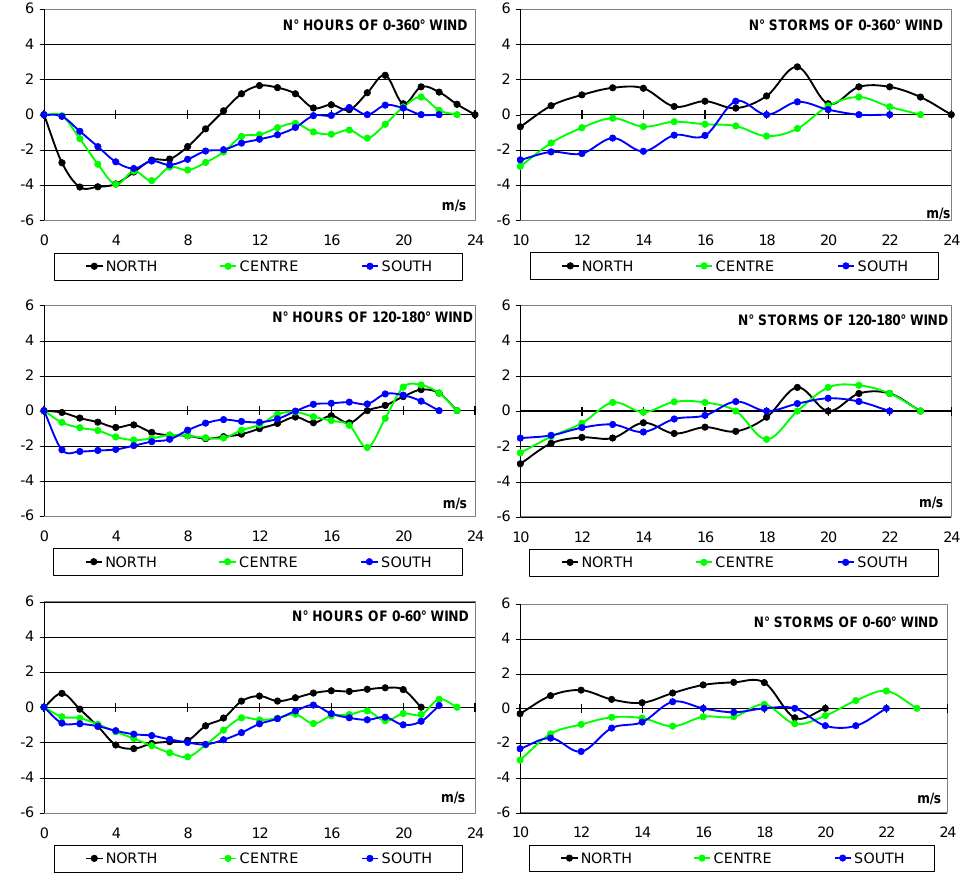
Figure 7. t-test statistics for cumulated number of hours above fixed wind speed thresholds (left side column) and for the number of storms (right column) at the North, Centre and South points in Figure 1. Upper row considers all wind directions, central row considers south-easterly winds (120 0 -180 0 ), bottom row north easterly winds (0 0 -60 0 ). Positive values of the t-test statistics indicate that frequencies are higher in the future than in the present period.